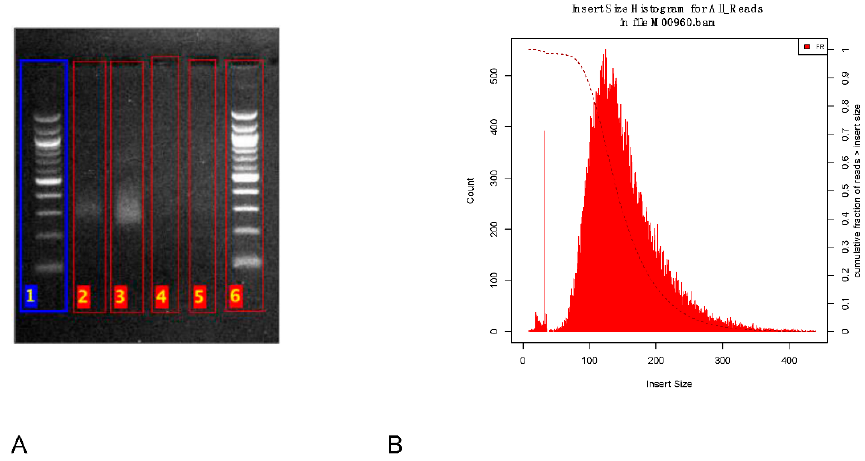
Figure 2. Library size estimation. ( A ) Agarose gel image showing the library size (smear at ~325 bp). Lanes 1, 6 represent 100 bp DNA ladders. Lanes 2–3 are undiluted libraries and lanes 4–5 are diluted libraries. ( B ) Library insert size estimated from the reads with Picard tool.